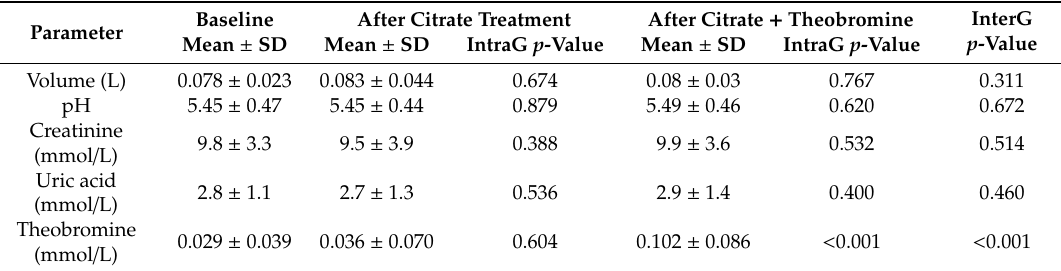
Table 2. Values in parameters for 2 h urine before and after the intervention (14 days). Values are given as mean ± SD. Intra-group analysis (before vs. treatment) used a paired-sample Wilcoxon signed-rank test or paired-samples t -test to determine the significance of differences. Inter-group analysis (citrate vs. citrate + theobromine) used analysis of covariances and comparison between groups after adjusting for baseline levels to determine the significance of differences.